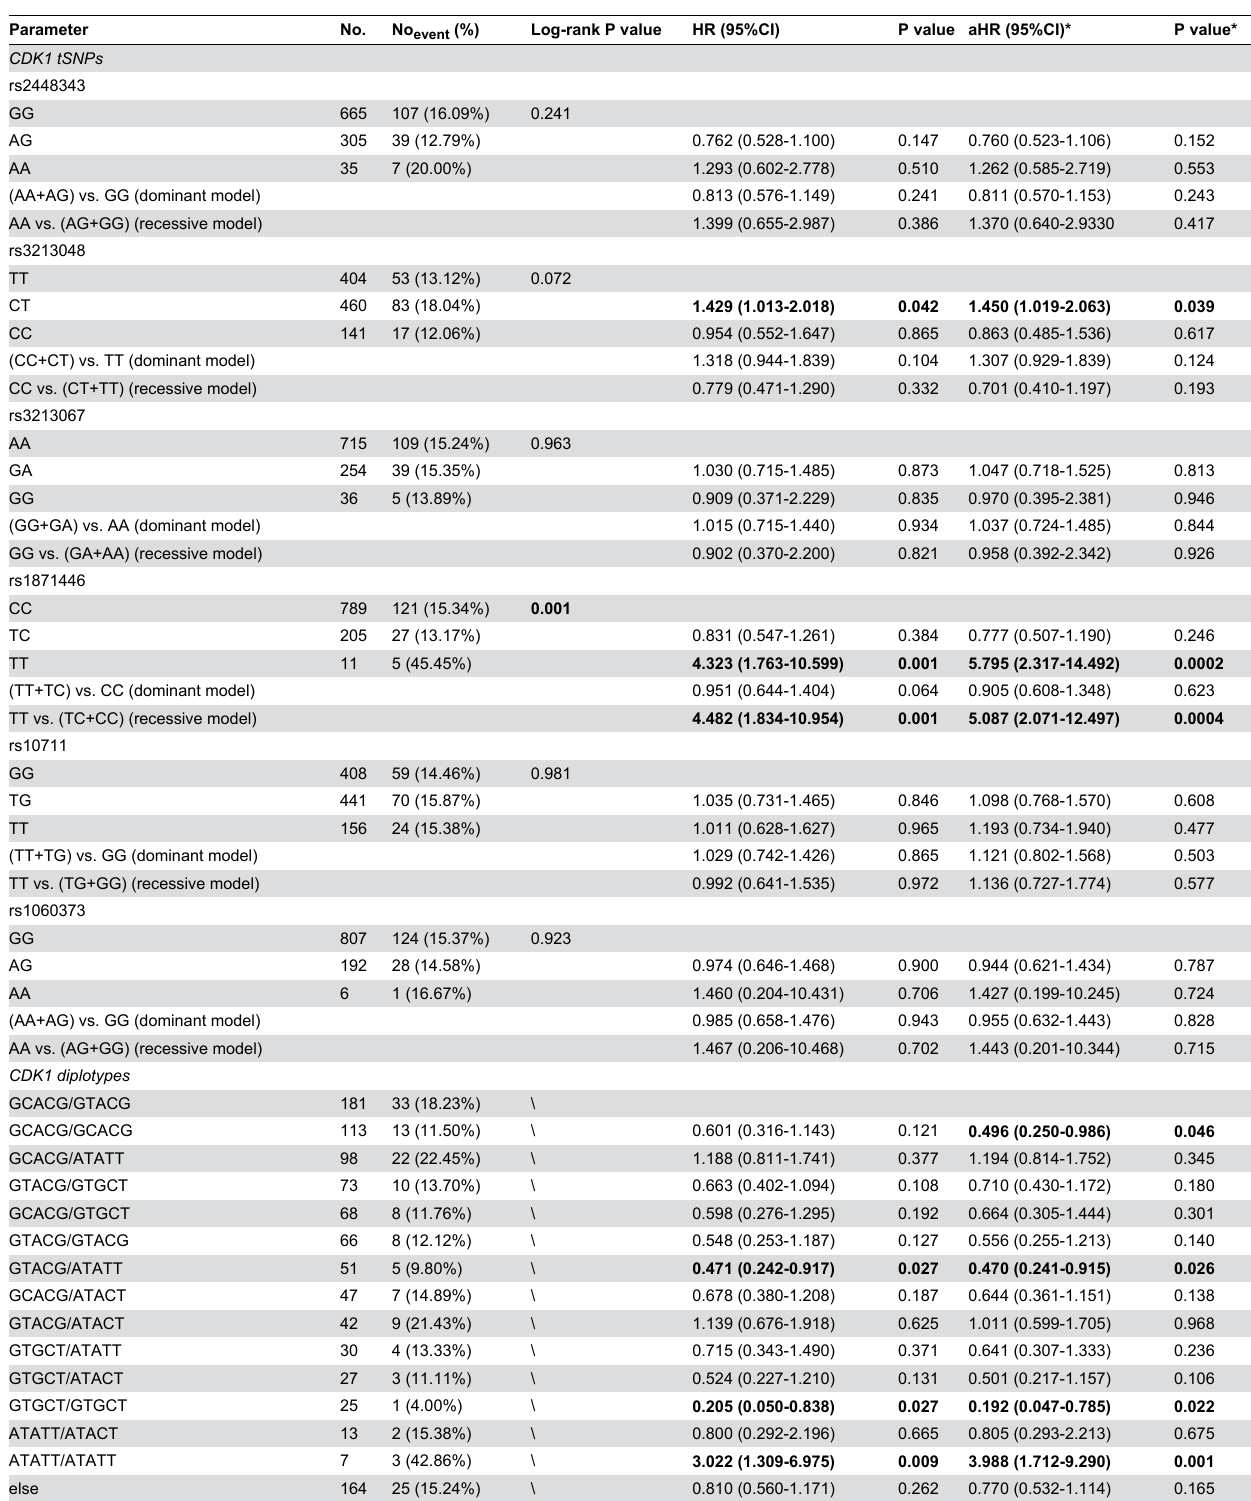
Table 5. Association analysis of the selected tSNPs, diplotypes in CDK1 in relation to event-free survival of breast cancer patients